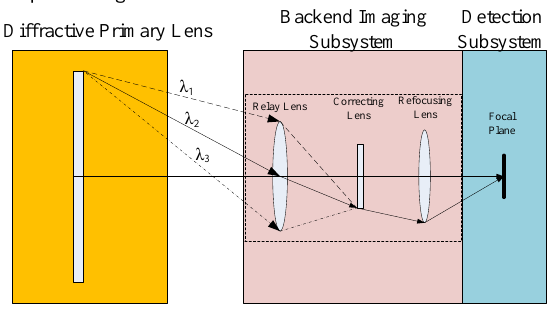
Figure 1. Concept of diffractive optical imaging remote sensor